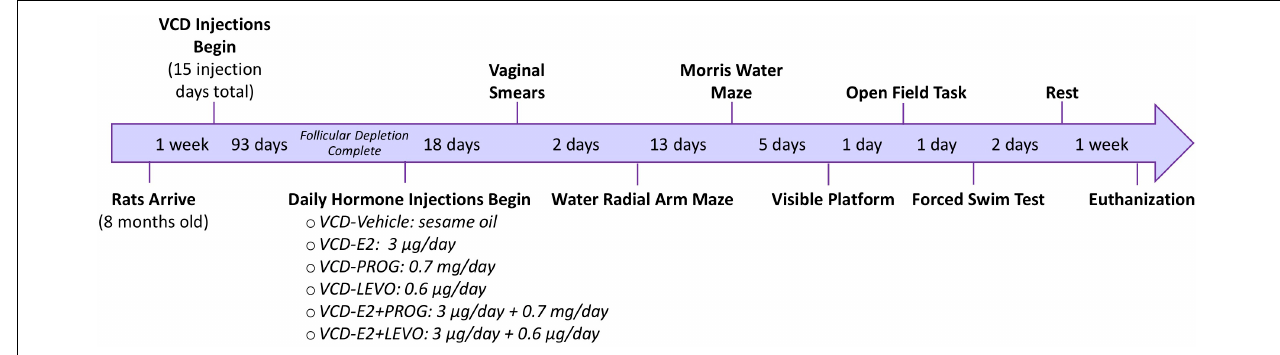
FIGURE 1 | Experimental Timeline. Following accelerated follicular depletion, rats received daily hormone treatments and were evaluated on a series of behavior tasks assessing working memory, reference memory, anxiety-like behavior, and depressive-like behavior.